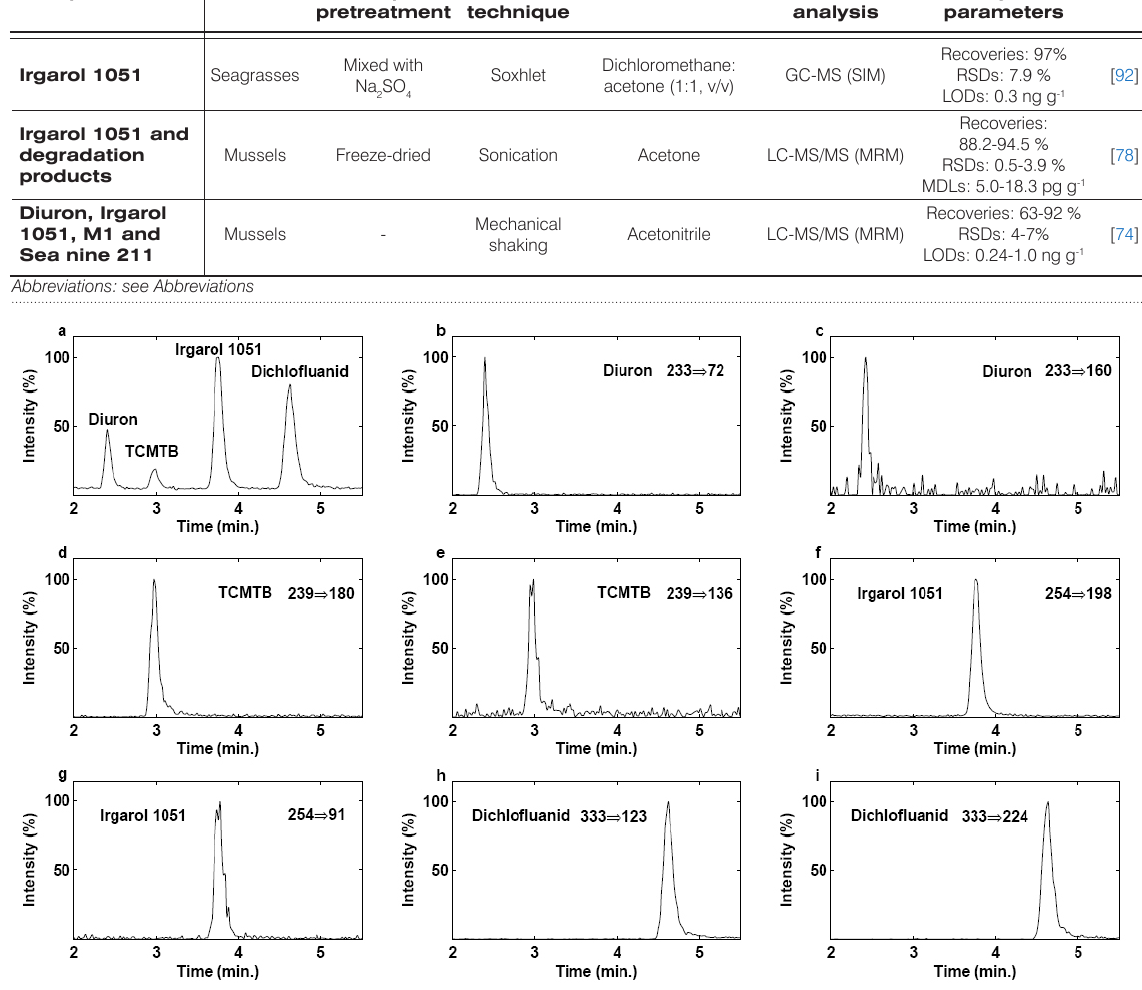
Figure 2. Total ion current (a) and selected ion (b-i) chromatograms obtained from a spiked seawater sample (10 ng L -1 ) by LC-MS under MRM mode. Chromatogram taken from